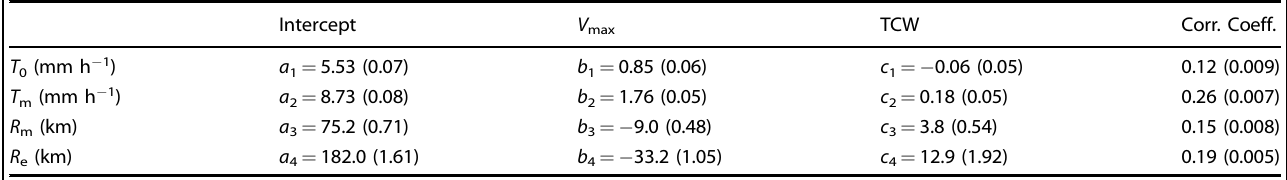
Table 1. The regression coef fi cients for the rainfall parameters to fi t the Eqs. 4 – 7, and correlation coef fi cients between the observed and predicted